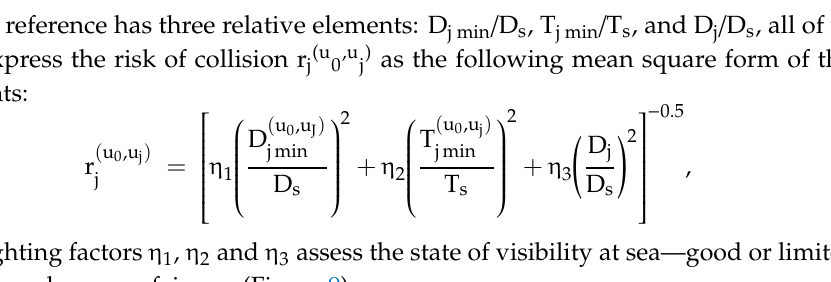
Figure 8. Object game trajectories calculated according to the pg c algorithm of the cooperative positional game control: on the left — with good visibility at sea, with the final payoff of the game ε f = 0.7 nmi achieved, assessing the deviation safe trajectory from reference cruise route; on the right — with limited visibility at sea, with the final payoff of the game ε f = 2.7 nmi.